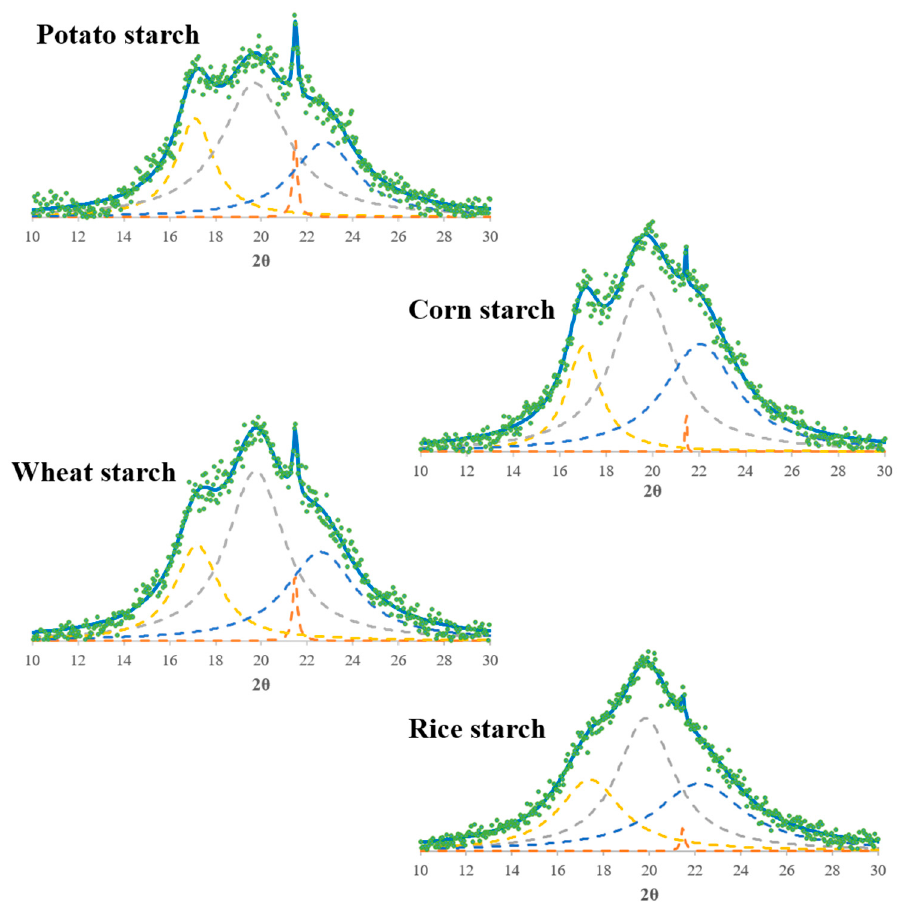
Figure 7. Deconvoluted XRD peaks of starch films obtained from potato, corn, wheat, and rice starch using the Lorentz function. Table 3. 2 θ peaks and their full widths at half maximum for the starch films obtained. Potato